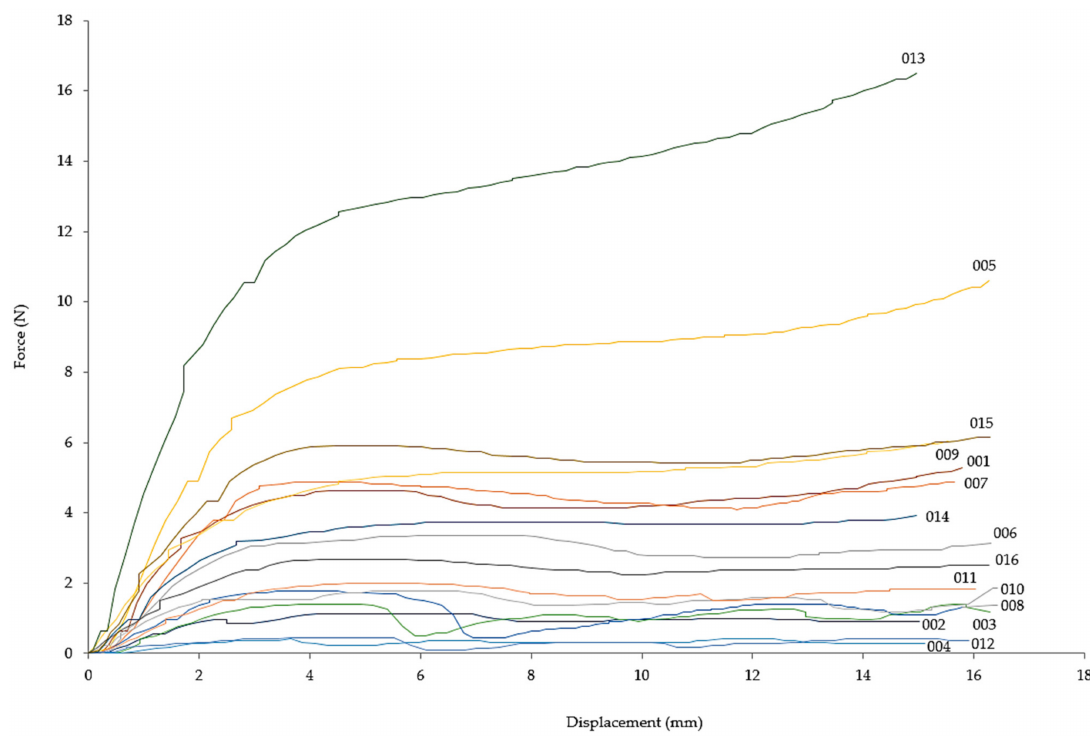
Figure 3. Force-displacement diagram of the compression tests for the 16 lattice configurations. Mean values and standard deviations for the elastic modulus, plateau stress, and energy absorption capacity for the 16 lattice configurations are presented in Table 5. The energy absorption capacity quantified in Table 5 was measured as the area under the stress-strain curve up to a value of 40% nominal strain. Table 5. Mean values and standard deviation for each lattice